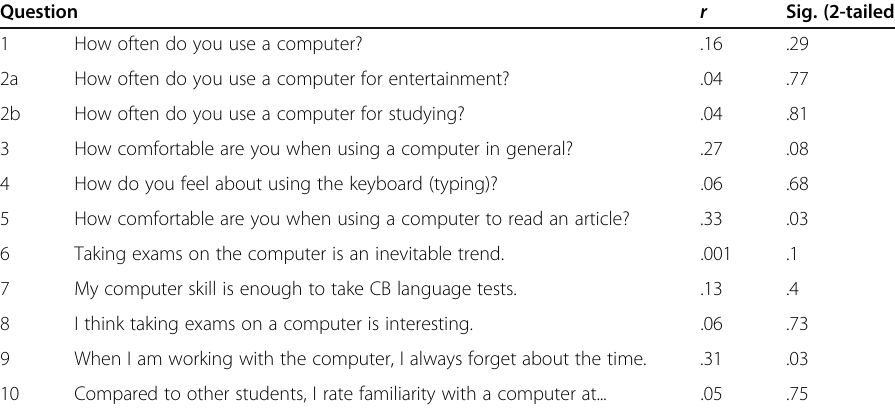
Table 6 Pearson correlation analysis of CB score on questionnaire